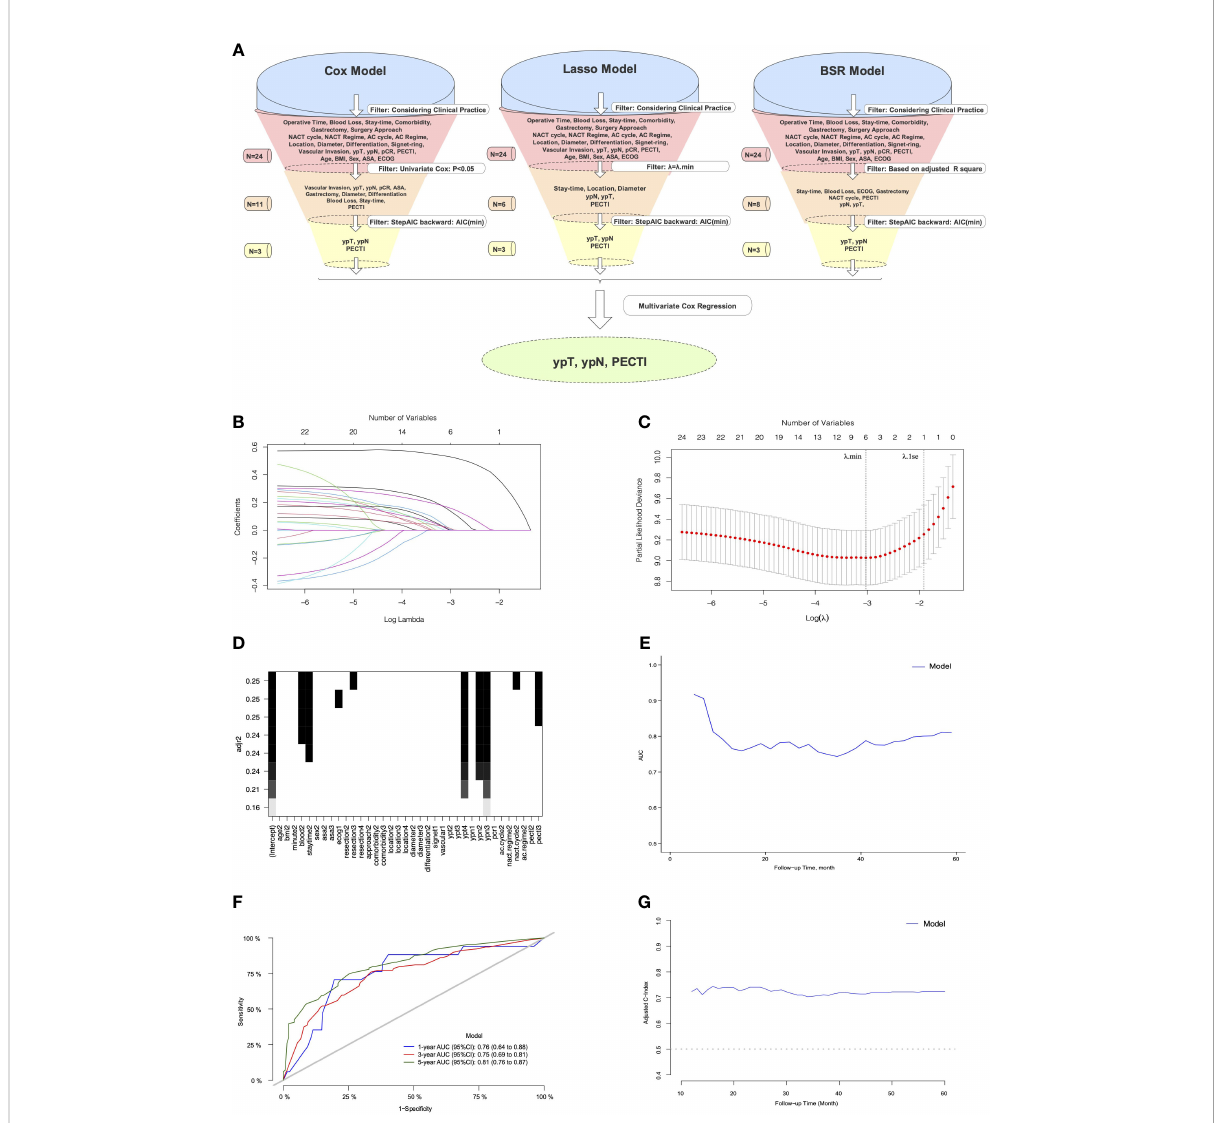
FIGURE 6 The process of variables into nomogram by fi ltration and discrimination of model. (A) The Illustration of Process. The variables were selected by comparison among the Cox, Lasso, and BSR models. Considering clinical practice, a total of 24 variables were eligible into models ’ fi ltration, respectively. First fi lter was different: variables from the Cox model was fi ltered through univariate Cox analyses (P <.05), and variables from the Lasso model was fi ltered through penalty parameter selection ( l = l .min), and variables from BSR model was fi ltered through adjusted R square. The remaining variables through the fi rst fi lter would be continued to be fi ltered through minimum backward stepwise AIC by second fi lter and multivariate Cox regression by third fi lter, respectively. The model consisting of eventually remaining variables would be chosen for development of prognostic Nomogram model. (B) The LASSO coef fi cient pro fi les of the 24 variables; (C) Tuning parameter ( l ) selection in the LASSO model. Dotted vertical lines were drawn at the optimal values using the minimum criteria ( l .min) and the 1 standard error of the minimum criteria ( l .1se); (D) Variable selection in BSR by adjusted R square. (E) The Model ’ s AUC with follow-up time. (F) The Model ’ s AUC in 1,3,5 years. (G) The Model ’ s adjusted C-index with follow-up time. Lasso, the least absolute shrinkage and selection operator; BSR, best subgroup regression; NACT, neoadjuvant chemotherapy; AC, adjuvant chemotherapy; pCR, pathological complete response; PECTI, perioperative chemotherapy time interval; BMI, body mass index; ASA, American Society of Anesthesiologists; ECOG, Eastern Cooperative Oncology Group; AUC, area under the curve; AIC, Akaike information